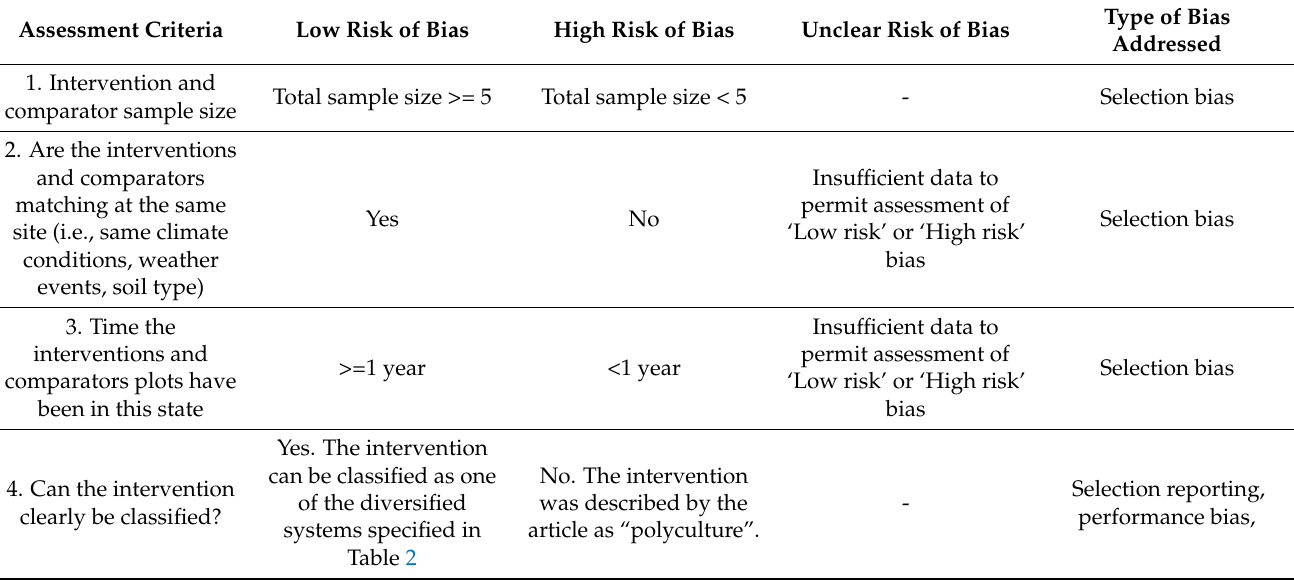
Table 3. List of criteria for observation validity